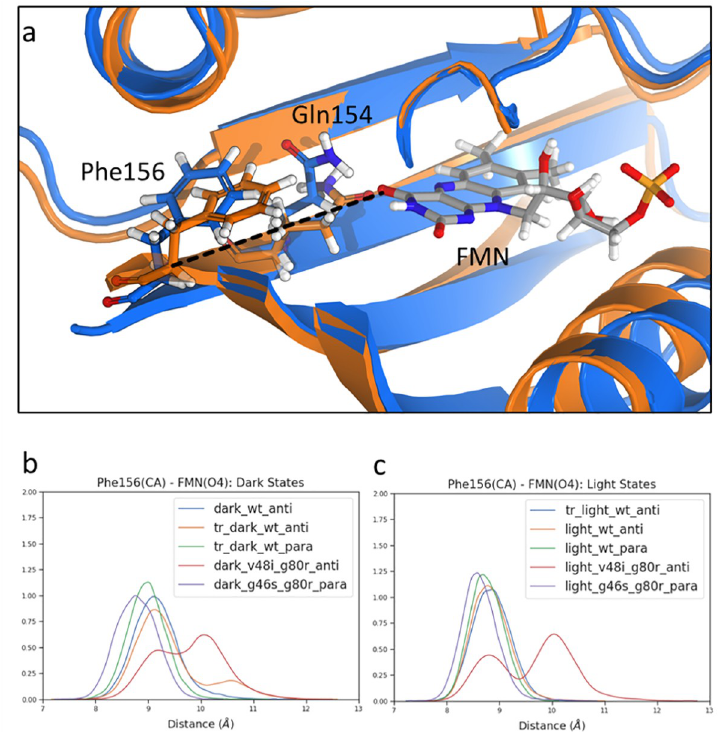
Fig 3. Light dependent I β strand pull investigation. a) Structure of the I β strand pull after Gln154 rotation. Dark state is represented in blue, and light state is represented in orange. Distance measured indicated by dashed line. b) Distribution of Phe156 CA and FMN(O4) distance for ZTL structures in the dark state. c) Distribution of Phe156 CA and FMN(O4) distance for ZTL structures in the light